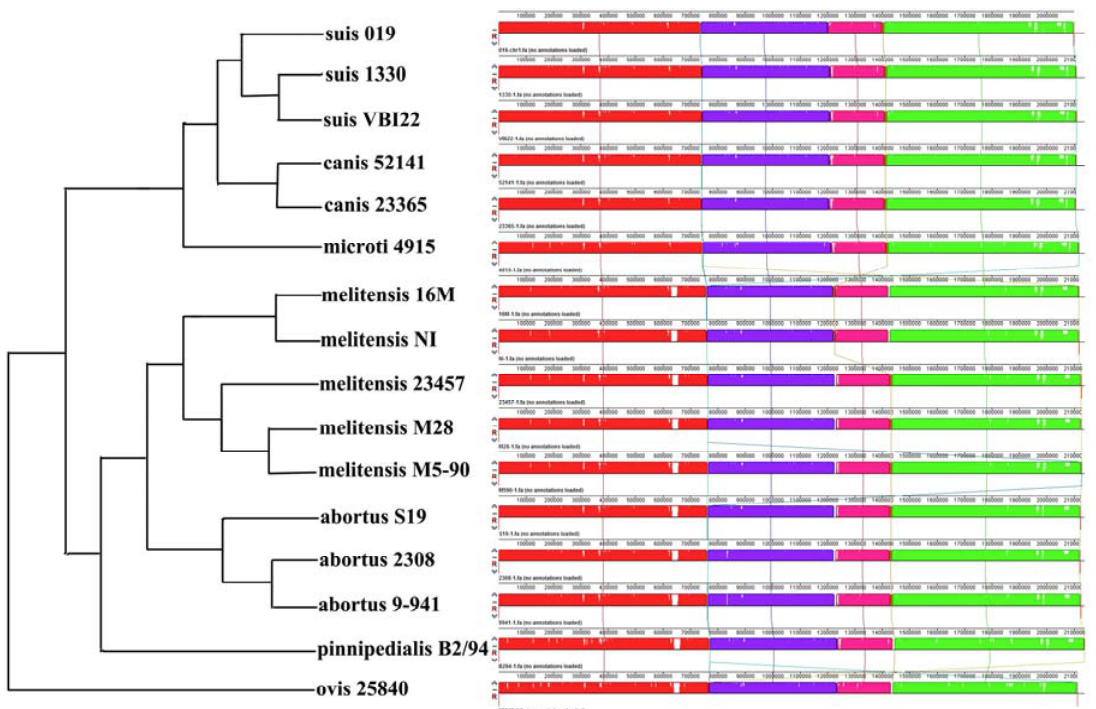
Figure 2. Nine LCBs on Brucella chromosome 1. Nine LCBs on chromosome 1 were built using 16 Brucella complete genomes. The blocks in the same color are connected by lines. A phylogenetic map of the strains derived from Phylogenetic Tree 2 (topology only) is on the left side.